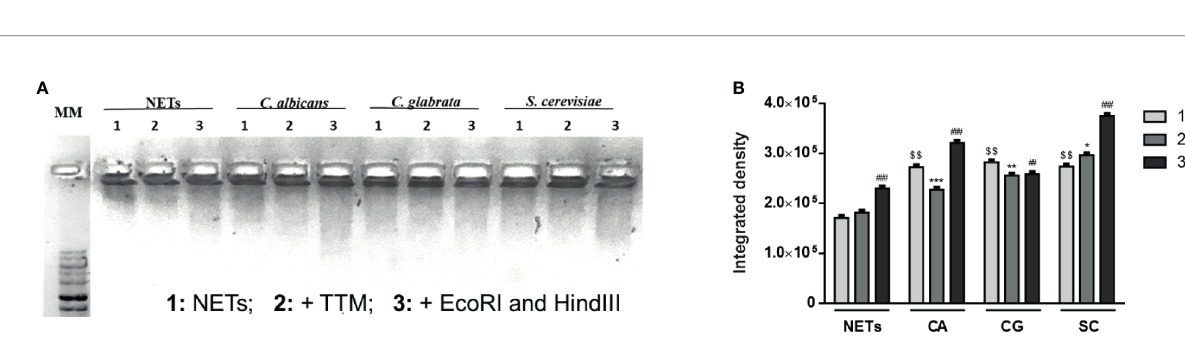
FIGURE 5 | Yeasts viability upon neutrophils interaction. C. albicans (CA), C. glabrata (CG) and S . cerevisiae (SC) colony forming unit (CFU) assays were performed at 1 h (A) and 3 h (B) post infection: supernatants were collected ( “ out ” columns) to access non-adhered/phagocytosed yeasts, and adhered neutrophils were lysed to release adhered/phagocyted yeasts ( “ in ” columns). Colonies were counted after 3 days, and data represent at least three independent experiments (means ± SEM). **p<0.01, ***p<0.001, in “ in ” vs. “ out ”